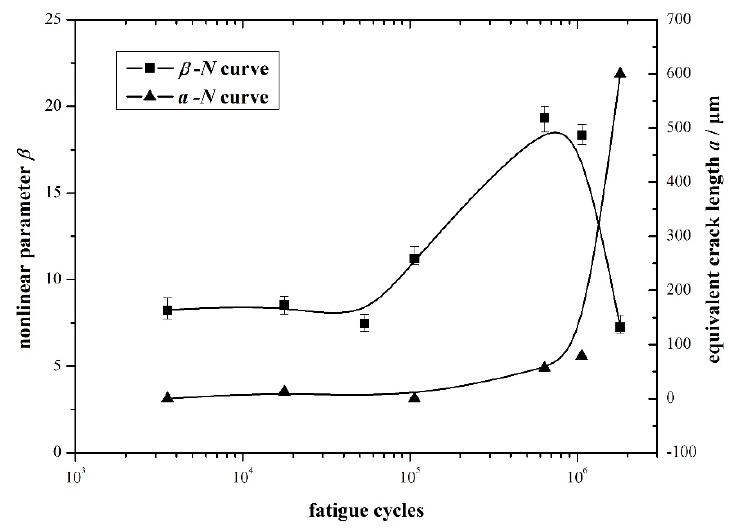
Figure 11. Relationship between nonlinear coefficient β , equivalent crack length, and fatigue cycles of the KMN vibration fatigue specimens. ( R 2 = 0.93 for β -N curve).